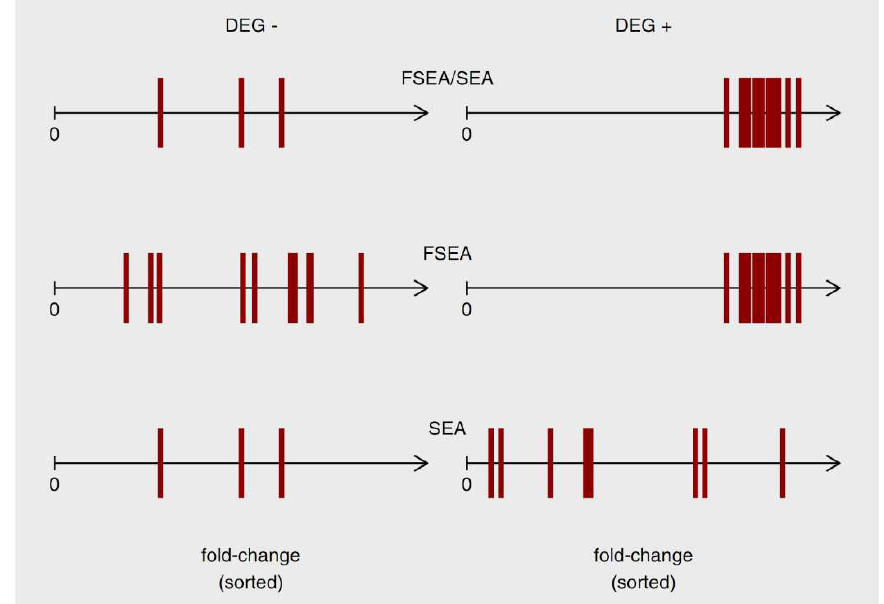
Figure 5. Schematic representation of three functionally-related groups identified as overrepresented in upregulated Differentially Expressed Genes (uDEGs) by Singular Enrichment Analysis (SEA), Fold-change-Specific Enrichment Analysis (FSEA), or both methods. Left and right halves of the plot refer to genes outside and inside uDEGs list, respectively. Genes annotated to the Gene Ontology (GO) term of interest denoted as red vertical bars on the scale of ascendingly sorted fold-change values.